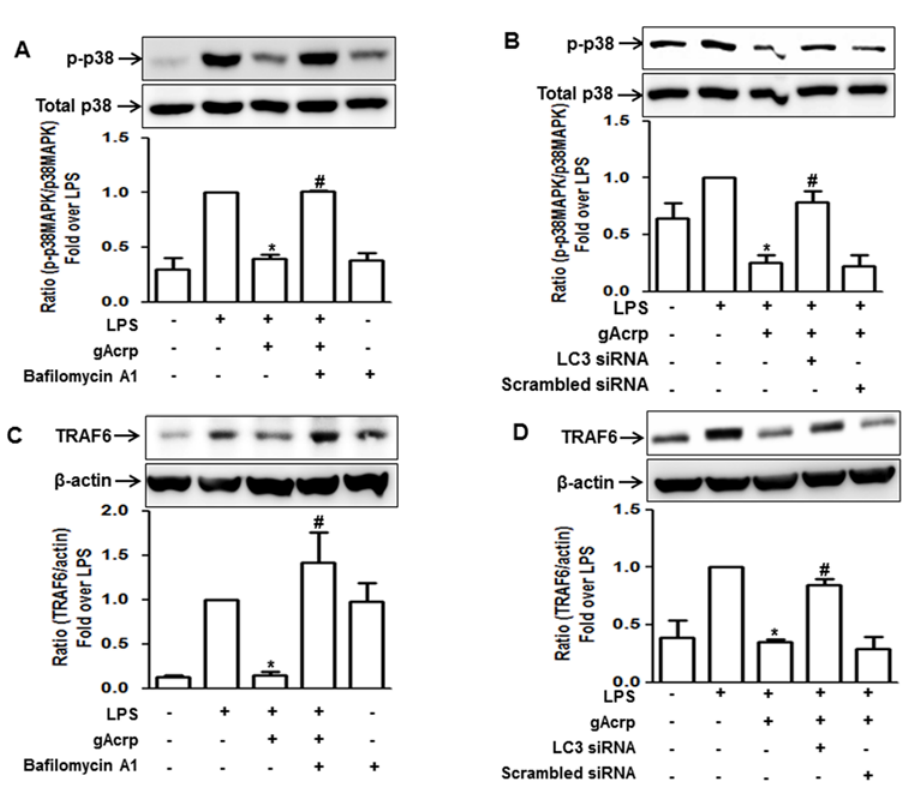
Fig 4. Role of autophagy induction in suppression of LPS-induced TRAF6 expression and p38MAPK phosphorylation by gAcrp. (A and C) Cells were pretreated with Bafilomycin A1 (10 nM) for 2 h followed by treatment with gAcrp (1 μ g/ml) for additional 24 h. Cells were then treated with LPS (100 ng/ml) for 30 minutes. (B and D) Cells were transfected with siRNA targeting LC3B (25 nM) or scrambled control siRNA. After 48 hours, cells were treated with gAcrp (1 μ g/ml) for 24 h, followed by treatment with LPS (100 ng/ml) for additional 30 minutes. Western blot analysis was performed to detect the level of phosphorylated p38MAPK (A, B) along with total p38MAPK, and TRAF6 (C, D) expression along with β -actin as an internal control. Representative images of three independent experiments that showed similar results are shown. Quantitative analysis of phosphorylated p38MAPK and TRAF6 expression were performed by densitometric analysis and are shown in the graph (lower panel of each figure). Values are presented as mean ± S.E.M. (n = 3). * P < 0.05 compared with LPS treated cell; # P < 0.05 compared to cells treated with LPS and